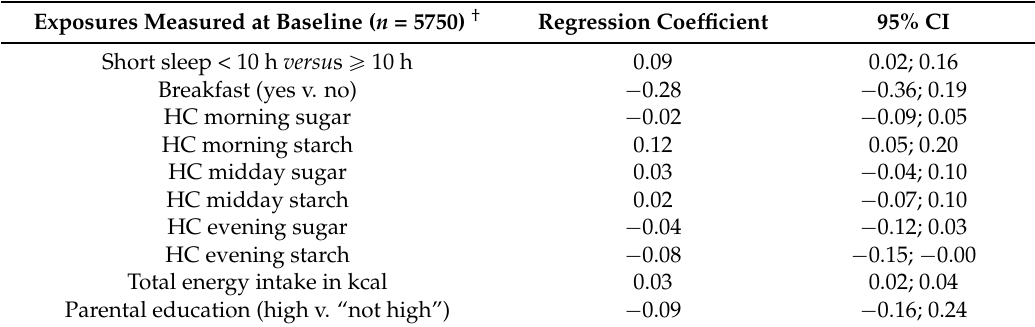
Table 3. High carbohydrate intake from sugar and starch at three times of day and short sleep duration and association with BMI z-scores at baseline, adjusted for age, sex and